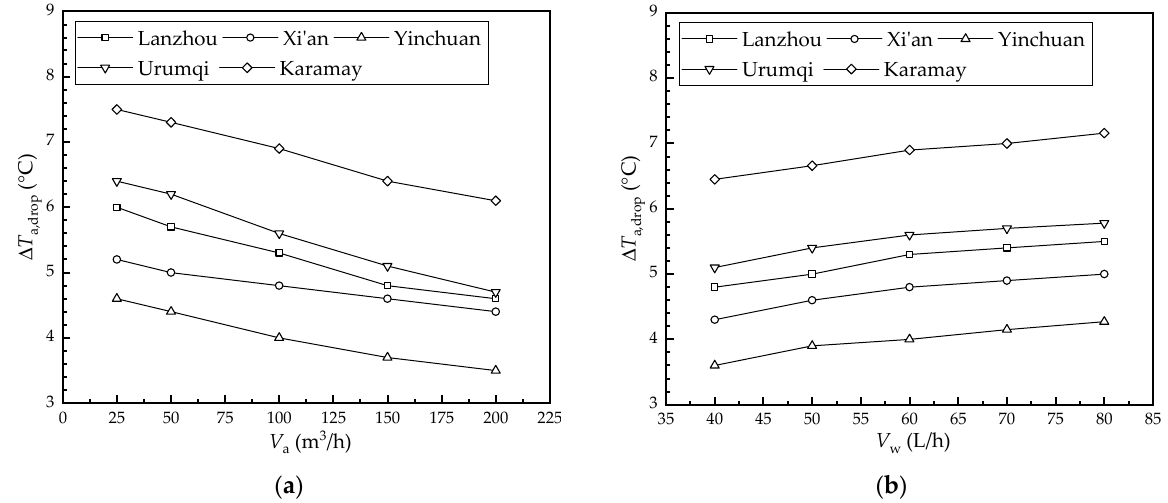
Figure 7. Effect of the flow rate on the air temperature drop in each city: ( a ) air flow rate; ( b ) water flow rate.